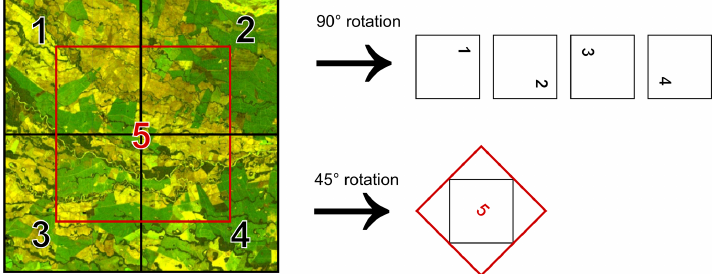
Figure A4. Data augmentation used in the training data. Sentinel-1 and Sentinel-2 were labeled in images 1000 × 1000 pixels in size. These training images were rotated 90 ◦ clockwise to increase the size and quality of the training dataset. We also applied a rotation of 45 ◦ in labeled images 2000 × 2000 pixels in size (image source: Copernicus Sentinel data 2019).